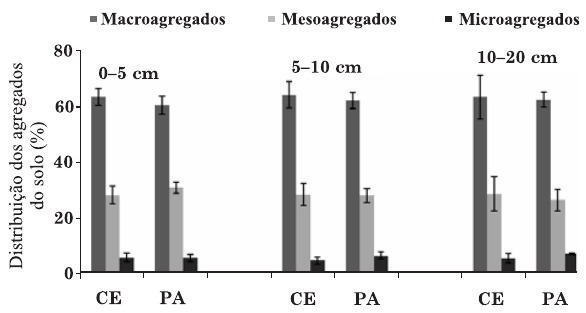
Figura 2. Distribuição das classes de agregados estáveis em água nas camadas de 0–5, 5–10 e 10– 20 cm (n=6) de um Latossolo Vermelho para a camada de 0–20 cm sob Cerradão (CE) e pastagem (PA) em Rio Verde (GO). Letras iguais dentro de uma mesma camada de solo não diferem pelo teste de Tukey (p <